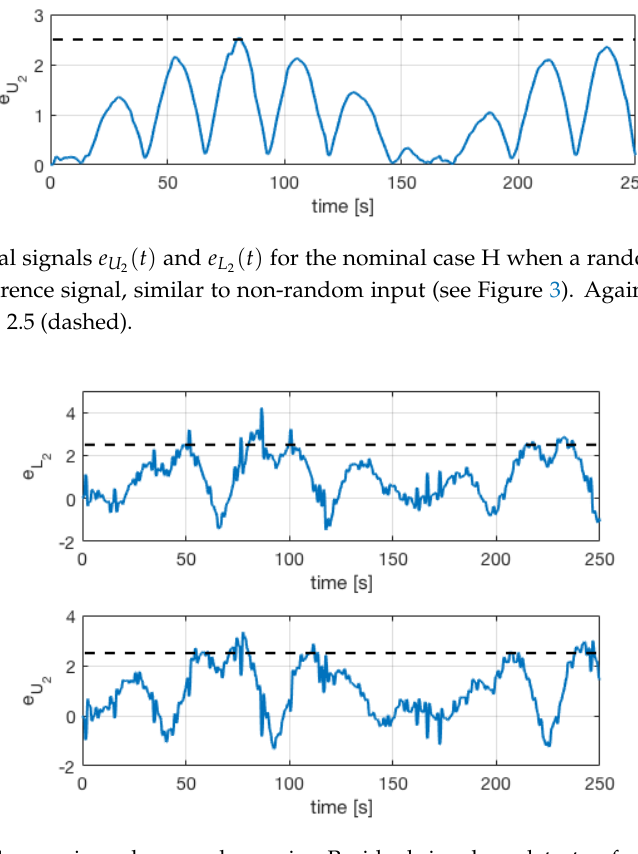
detects a faulty behavior due to 2